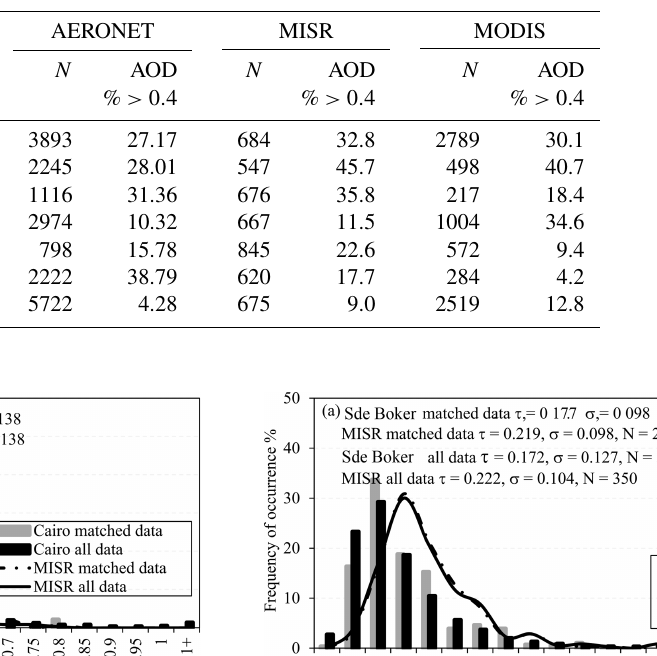
Table 4. MISR coverage for 6 days of major dust activity over the Arabian Peninsula during March 2009.